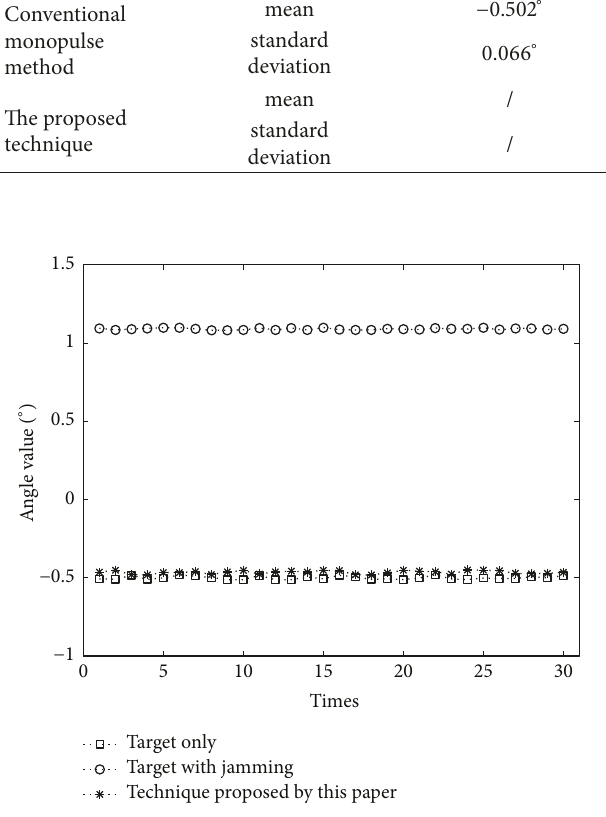
Figure 7: Angle estimation of the target being interfered with by the corner reflector and active jamming simultaneously. Table 2: Success rate of countering angle deception